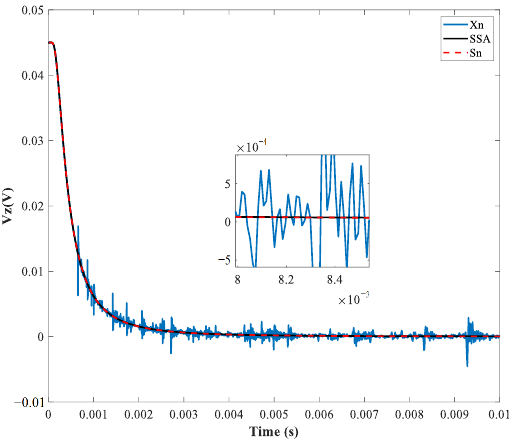
Figure 8. Comparison of signals before and SSA de-noising.